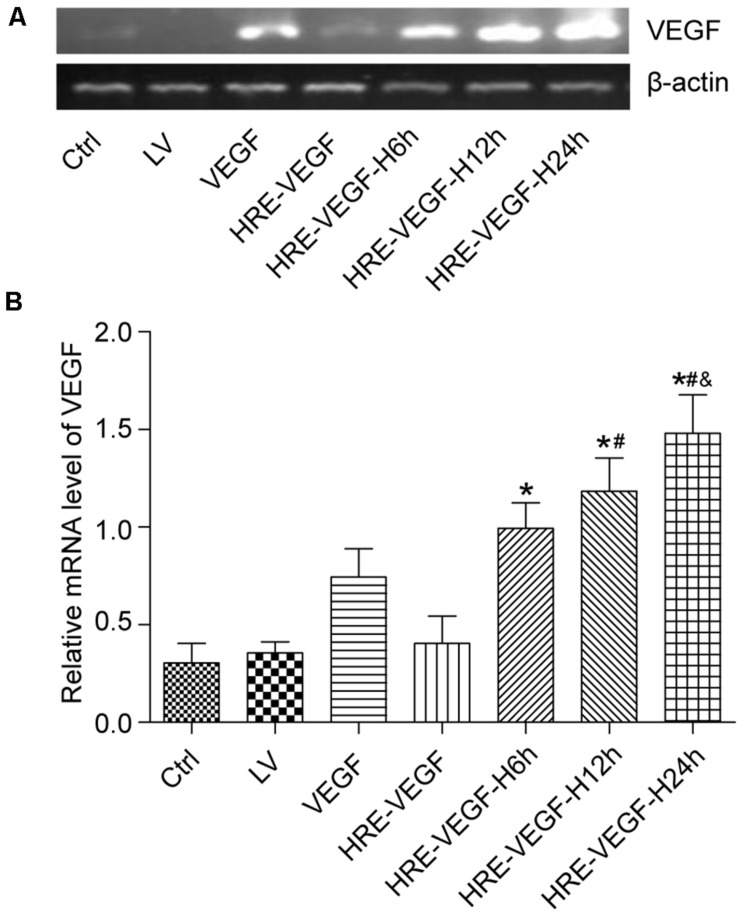
The measured expression of VEGF165 mRNA in each group. (A,B) Determination of VEGF165 mRNA by Nucleic acid gel electrophoresis for different transfection conditions in NSCs. Data were expressed as mean ± SD, one-way analysis of variance (ANOVA). (*p < 0.05 compared with HRE-VEGF, #p < 0.05 compared with HRE-VEGF-H6h, and &p < 0.05 compared with HRE-VEGF-H12h).